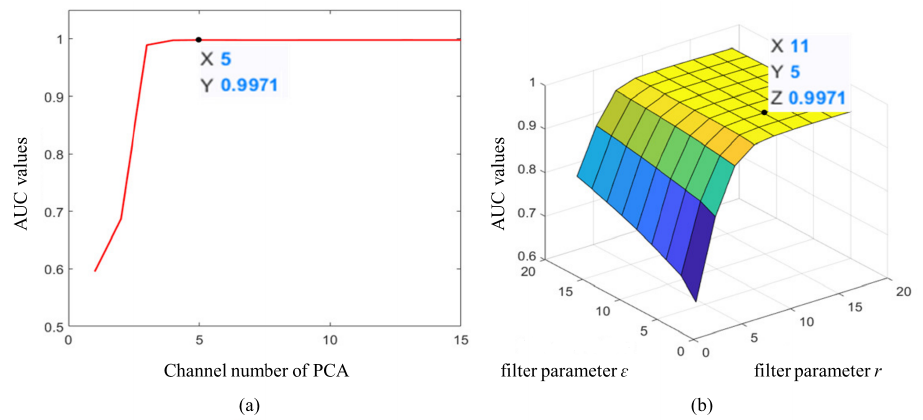
Figure 4. Examples of AUC values under different parameters of our framework: ( a ) AUC values on the first datasets corresponding to different numbers of dimensionality-reduction maps; ( b ) AUC values under different filter parameter r and ε